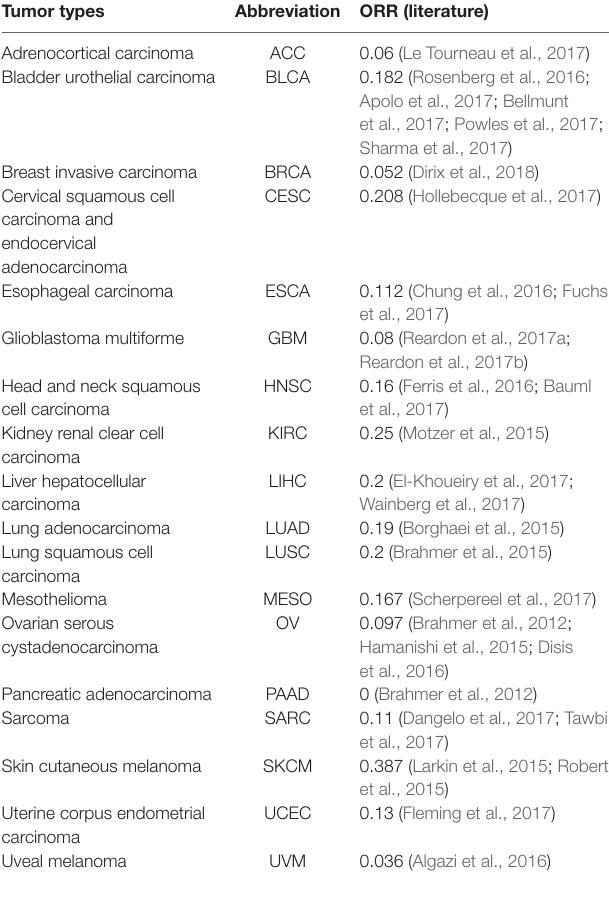
TABLE 1 | Objective response rates (ORRs) collection of 18 cancer